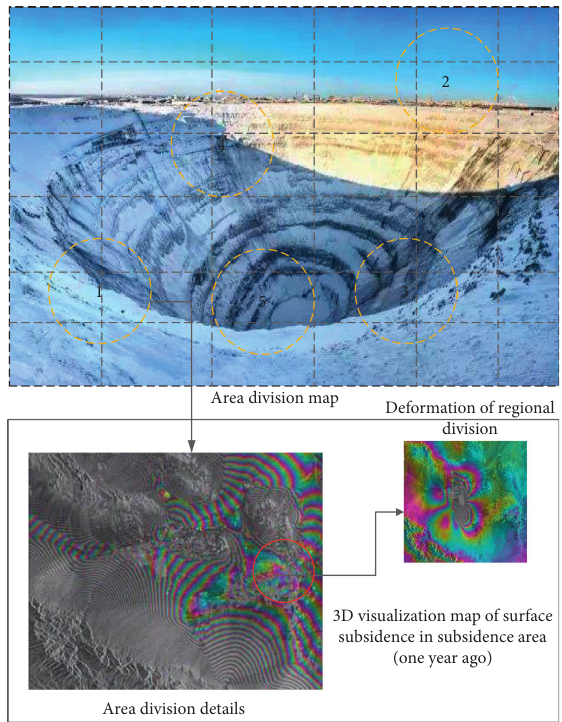
Figure 15: 3D visualization map of surface subsidence in subsidence area (one year ago). Table 2: Comparison of experimental data in area